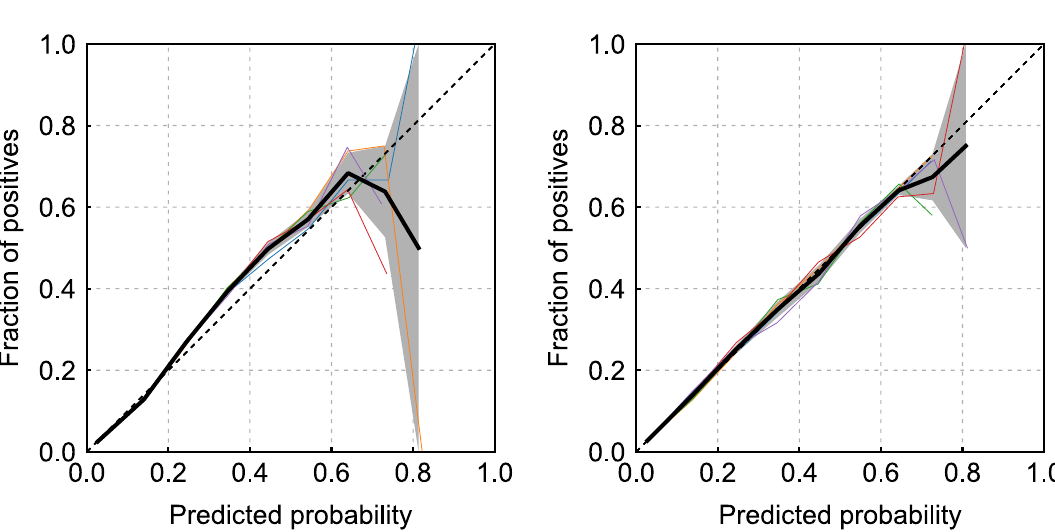
Figure 2. Reliability diagrams for the LR model (left) and LightGBM (right). The horizontal and vertical axes are the predicted probabilities and fraction of positives. There are five curves owing to the 5-fold cross-validation method. The thick black line is the mean of five curves, and the gray area represents the standard